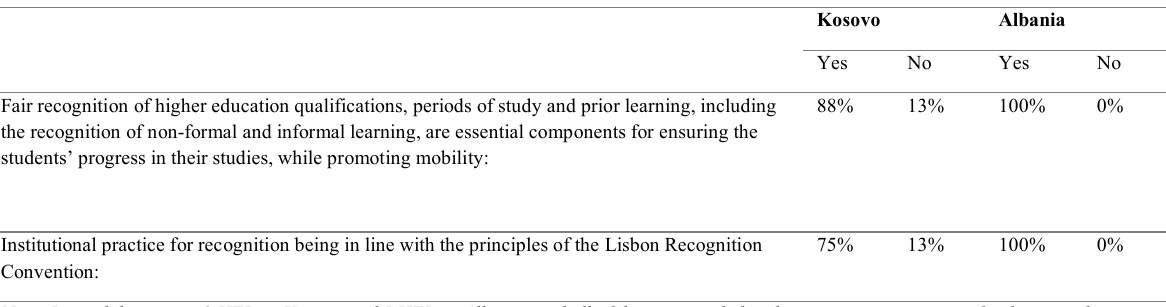
Table 5 : Internal Quality Assurance: Question number 6 and 7 for the HEIs in Kosovo and Albania